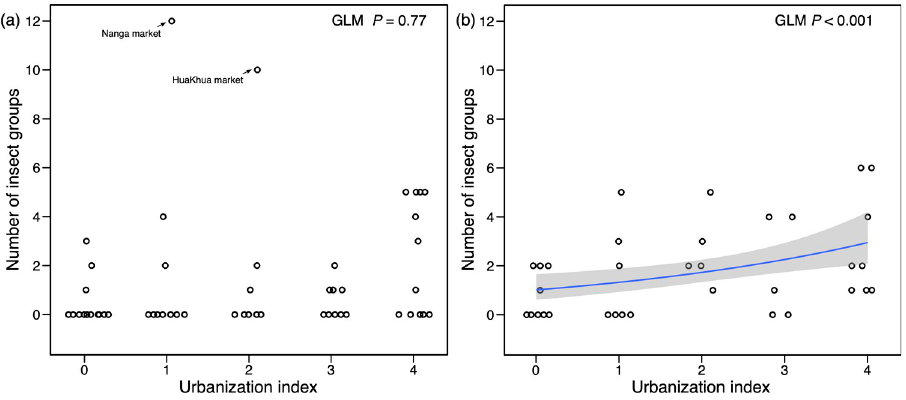
Fig 4. Relationship between the number of groups of insects sold at food markets and urbanization index. (a) Dry season, (b) Rainy season. Circles indicate the number of insect groups sold at each market. Blue line represents the fitted curve by a generalized linear model with Poisson distribution (log link